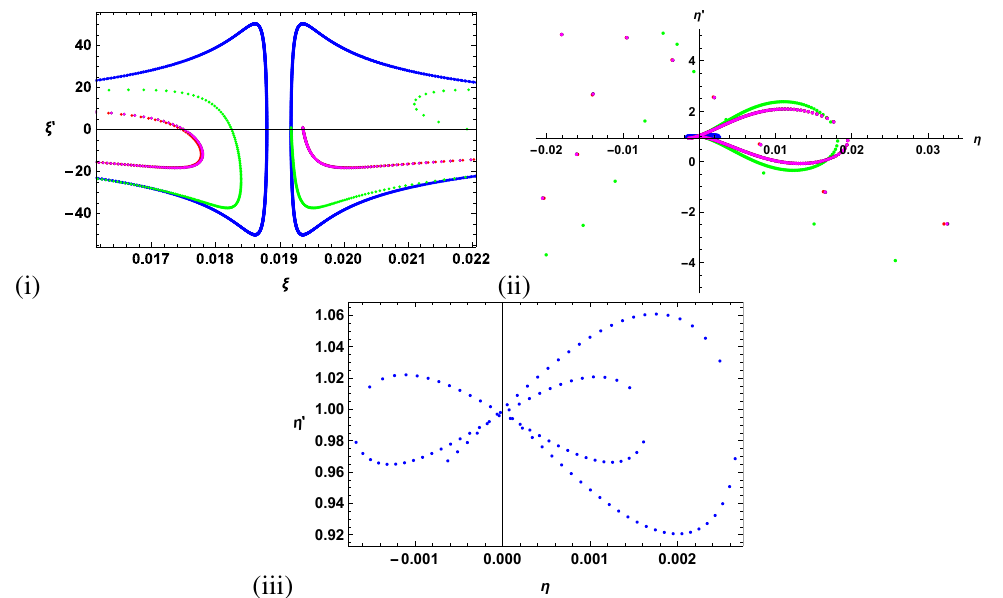
Fig. 5 Poincaré surface of sections for five cases: (a). Third primary is placed at one of the lagrangian points of the classical circular restricted three-body problem (with blue color), (b). Variation of masses (with green color), (c). Solar radiation pressure (with red color), (d). Albedo effect (with black color), (e). Oblateness effect (with magenta color). (i) Poincaré surface of sections in ξ − ξ (cid:48) -plane, (ii) Poincaré surface of sections in η − η (cid:48) -plane, (iii) Zoomed part of figure (ii) near the